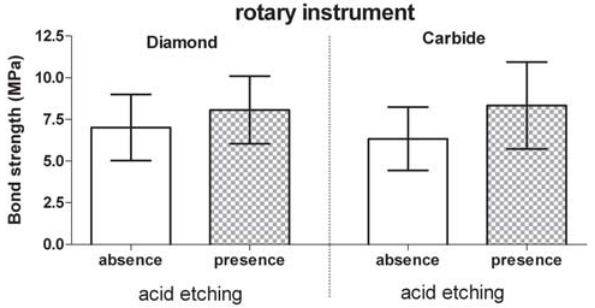
FIGURE 1- Shear bond strength means (MPa) and standard deviation by type of instrument (diamond and carbide) and acid etching (presence and absence)